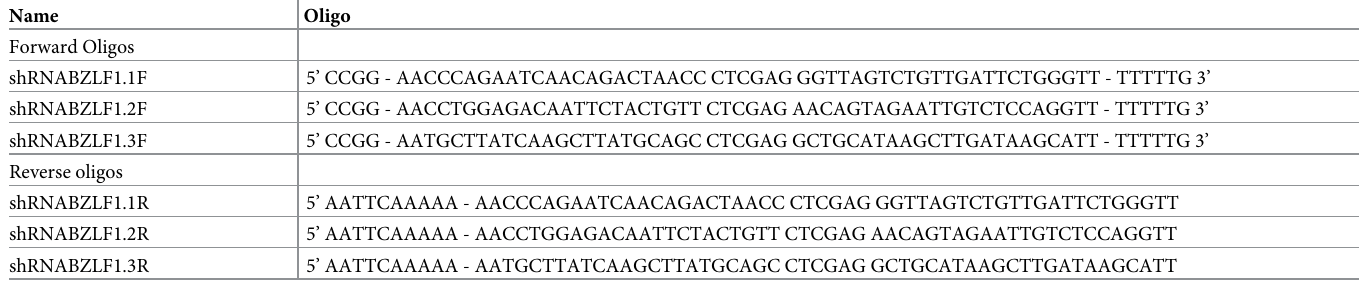
Table 2. The oligos used to generate BZLF1